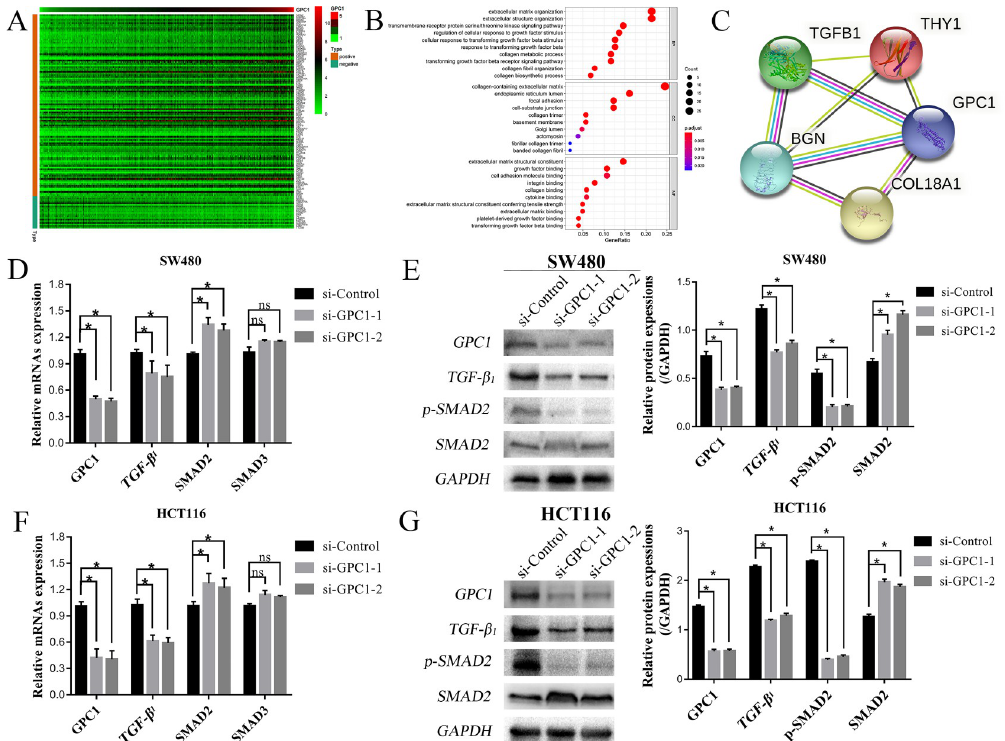
Fig 6. Pathway enrichment analysis and TGF- β signaling pathway identification in CRC. (A). Correlations between GPC1 and target genes in CRC. (B). GO analysis showed that the TGF- β signaling pathway was enriched in CRC. (C). The correlation-target network for GPC1. (D–G). GPC1-associated mRNAs and proteins were examined by qRT-PCR and western blot analysis in SW480 and HCT116 cell lines after silencing GPC1.